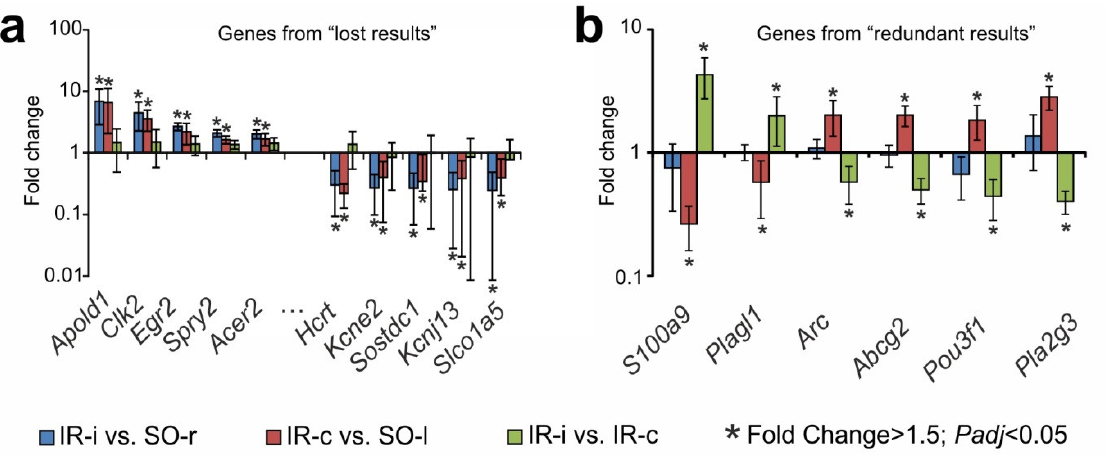
Figure 4. Genes that were DEGs in IR-c vs. SO-l and overlapped with sets of “lost” ( a ) and “re- dundant” ( b ) results, respectively. ( a ) The top 10 genes that exhibited the greatest fold change in expression in IR-c vs. SO-l were DEGs in IR-i vs. SO-r but non-DEGs that exhibited a fold change <1.50 in IR-i vs. IR-c. ( b ) The genes that were DEGs in IR-c vs. SO-l and IR-i vs. IR-c but non-DEGs in IR-i vs. SO-r. The data are presented as the mean ± SE.